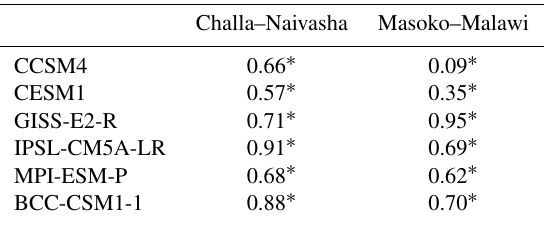
Figure 6. Mean annual precipitation minus mean annual evapora- tion (horizontal bars), and standard deviation of annual precipitation minus the standard deviation of annual evaporation (vertical bars) using the entire last-millennium results (850–2005) for each GCM. Red (blue) colour means that evaporation (precipitation) dominates. Table 2. Pearson correlation coefficients between simulated rainfall and simulated evaporation in the Challa–Naivasha and Masoko– Malawi regions over the pre-industrial portion of the last millen- nium (850–1850